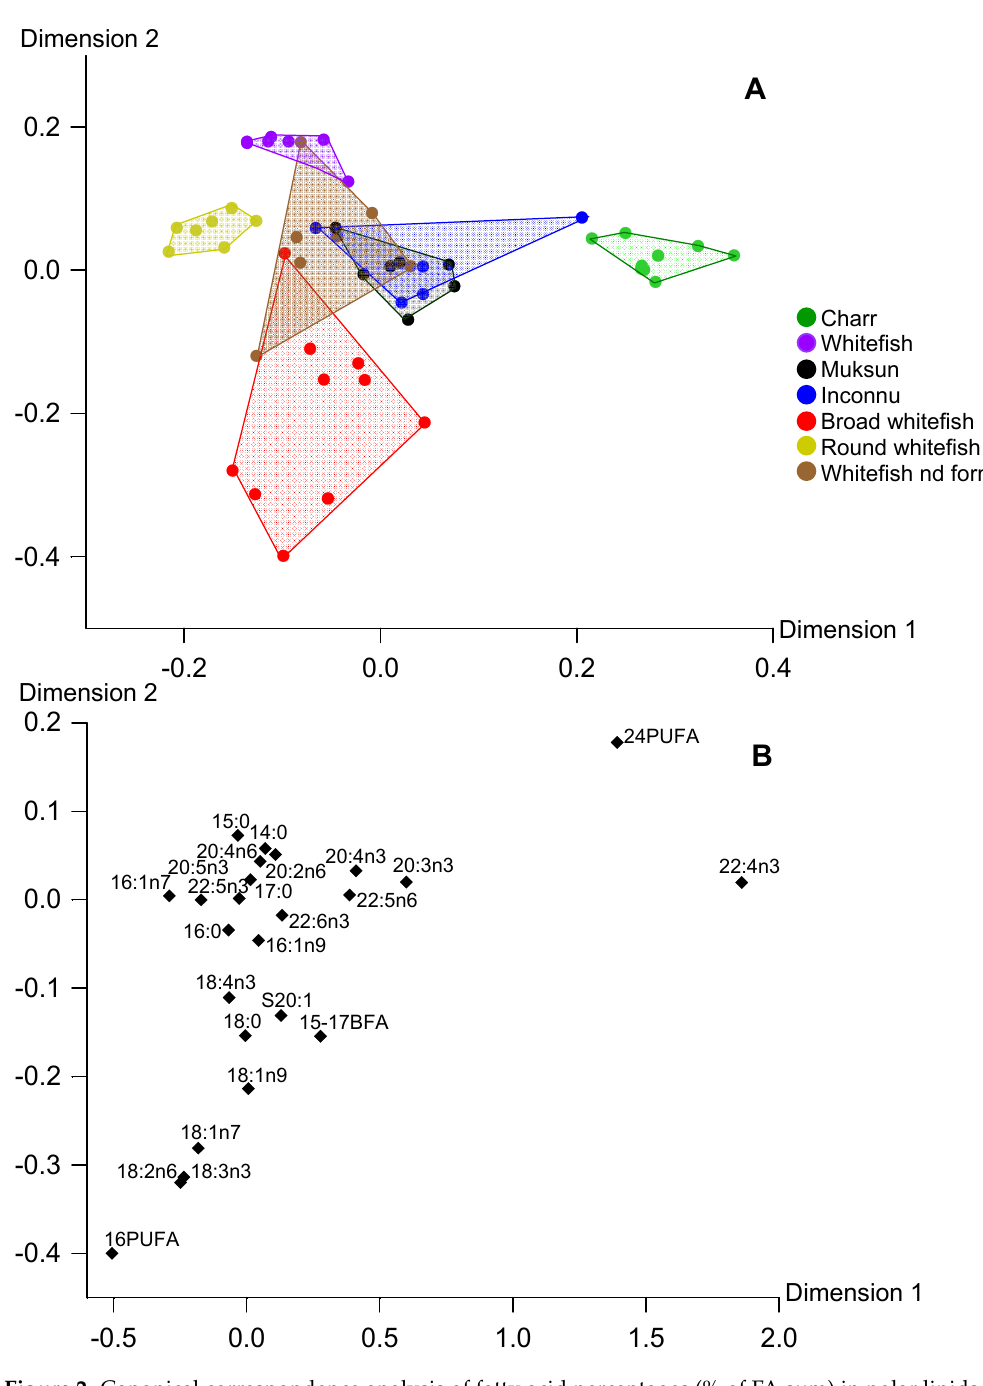
Figure 2. Canonical correspondence analysis of fatty acid percentages (% of FA sum) in polar lipids of muscles of seven fish species from arctic lakes (Siberia, Russia). A – individual variables, B ‐ factor structure coefficients for fatty acids. Dimension 1 and Dimension 2 represented 30.9% and 22.5% of inertia, respectively.